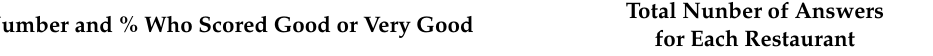
Table 4. Percentage of UK restaurant chains scored by adult patients or parents/caregivers of children with PKU scoring “good or very good” for their provision of low protein